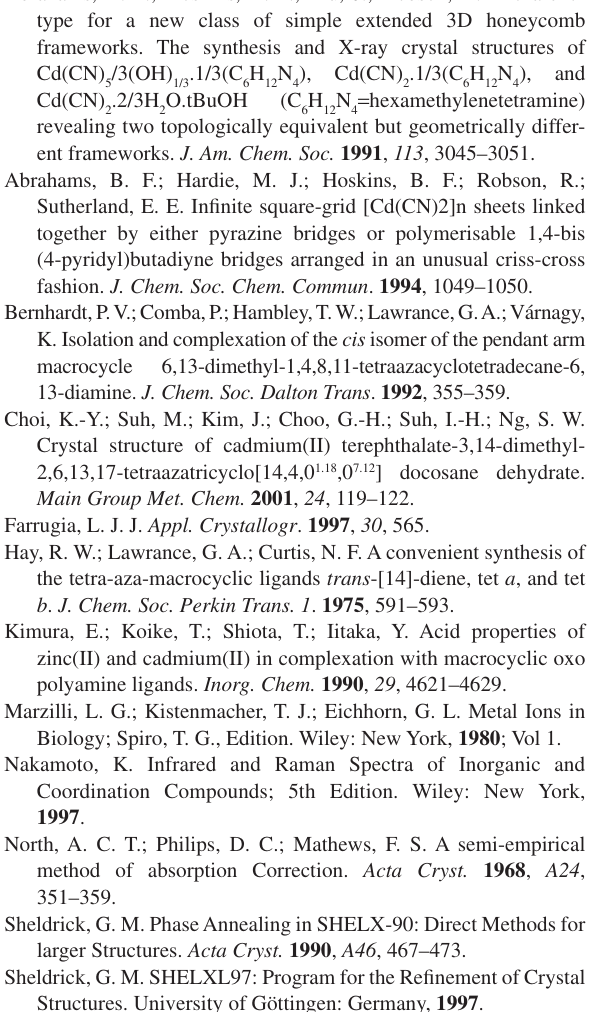
Table 2 Crystallographic data for [Cd(L)( µ -Cl)]